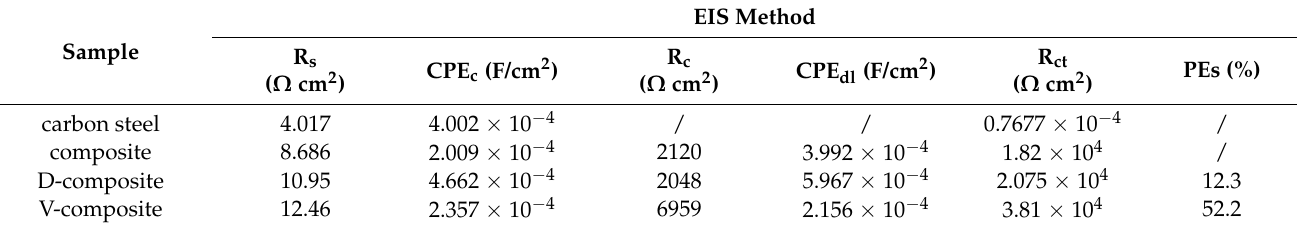
Figure 7. Potentiodynamic polarization curves and EIS studies. ( a ) Tafel plots of composite, D-composite, and V-composite measured in 3.5 wt% NaCl solution with the voltage selection range before and after the open circuit voltage of 300 mv and a scan rate of 5 mV/s; ( b ) Nyquist plots of composite, D-composite, and V-composite measured in 3.5 wt% NaCl solution at the open circuit voltage and frequency ranging from 10 kHz to 0.01 Hz; and ( c ) EIS phases and magnitude of the total impedance of composite, D-composite, and V-composite. Table 2. Fitting corrosion characterizations for the coating samples after immersion in a 3.5% NaCl so- lution for 2 days by electrochemical corrosion measurements via the EIS method, and electrochemical corrosion measurements (SCE was employed as a reference